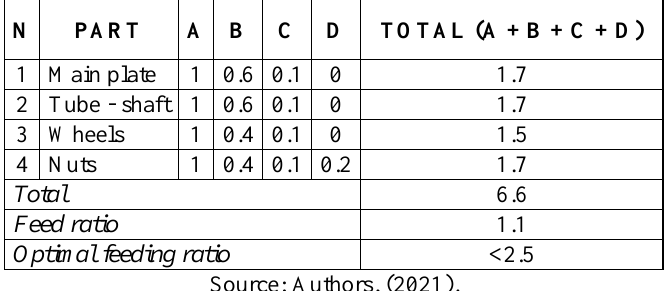
Table 5: Result of the conceptual landing gear handling analysis.